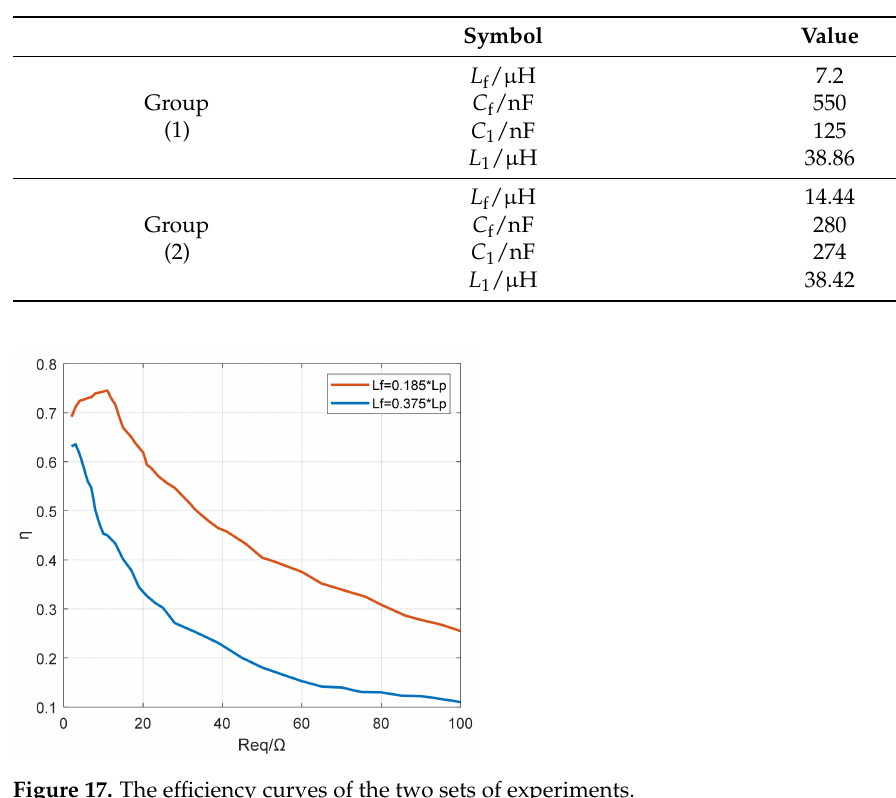
Table 2. System specific parameters in the two sets of experiments.